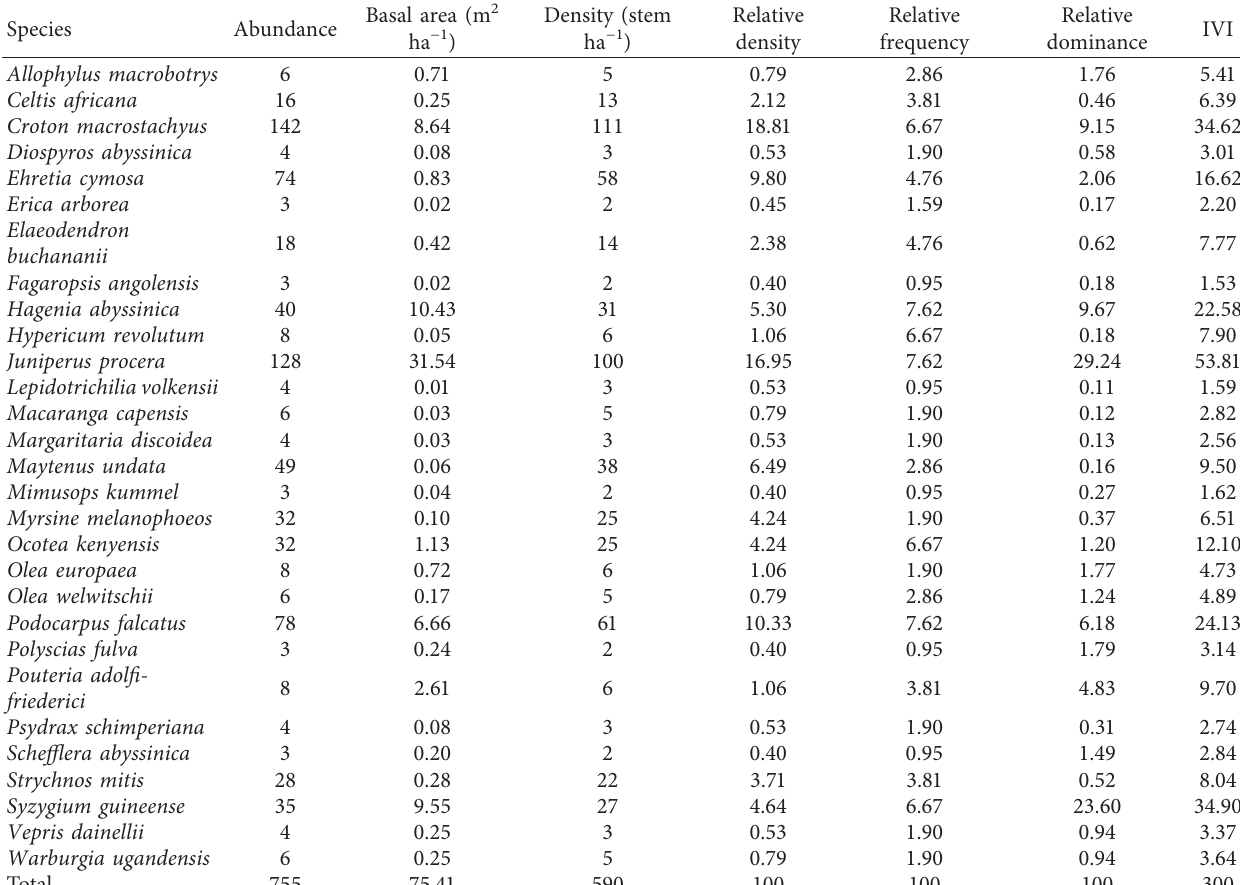
Table 5: Woody species structure in the interior habitats of the BMNP.